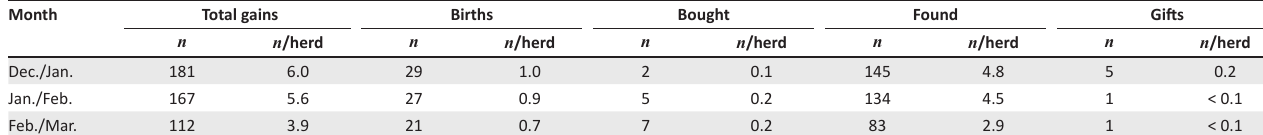
TABLE 3: Average gains of cattle reported per herd per month. Month Bought